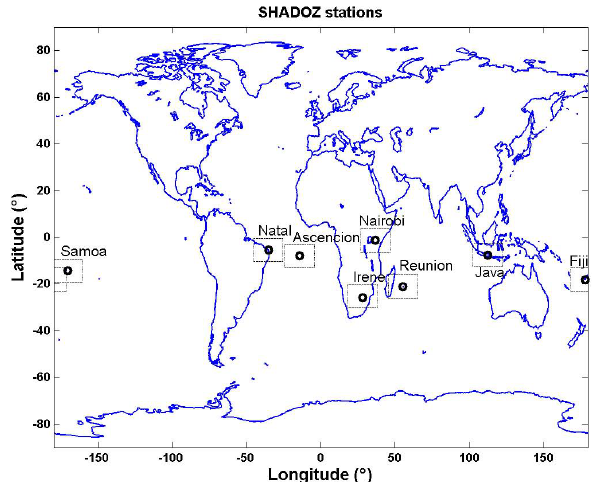
Fig. 1. Map of SHADOZ stations in the Southern Hemisphere. Ozone profiles obtained by radiosonde experiments at 8 stations (black circles) are used for the purpose of the present study, from west to east: Samoa, Natal, Ascension Island, Irene, Nairobi, Re- union, Java and Fiji. The regions where GOMOS profiles are se- lected within ± 5 ◦ latitude and ± 10 ◦ longitude differences over each station are also represented (dotted